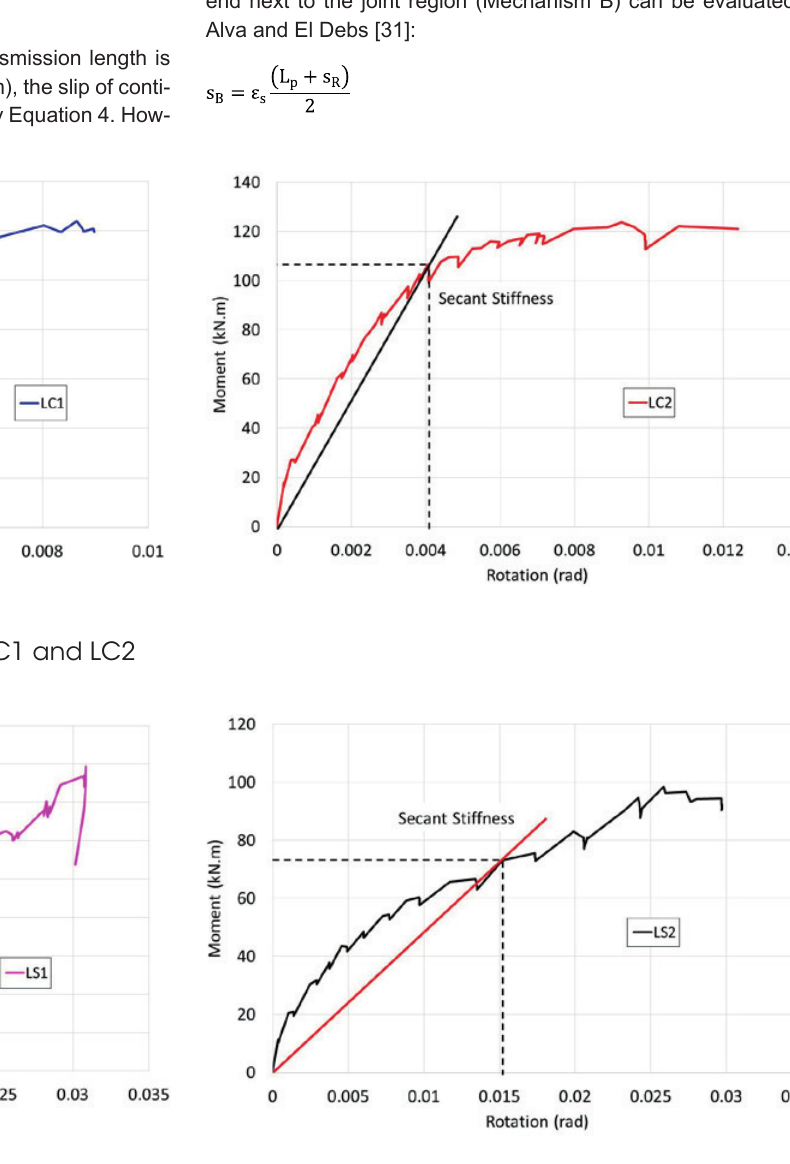
Moment-rotation curve: specimens LS1 and LS2